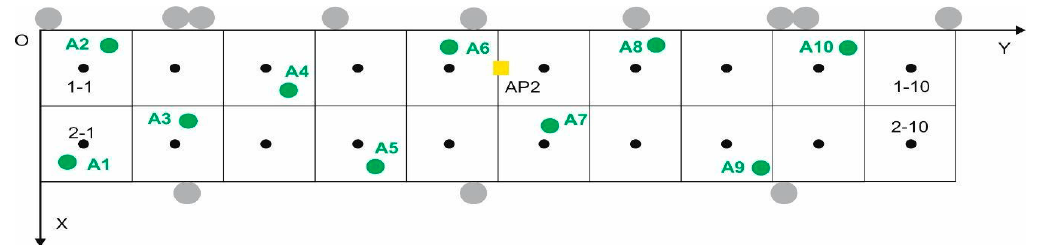
Figure 11. Distribution of the 10 random points or target points.